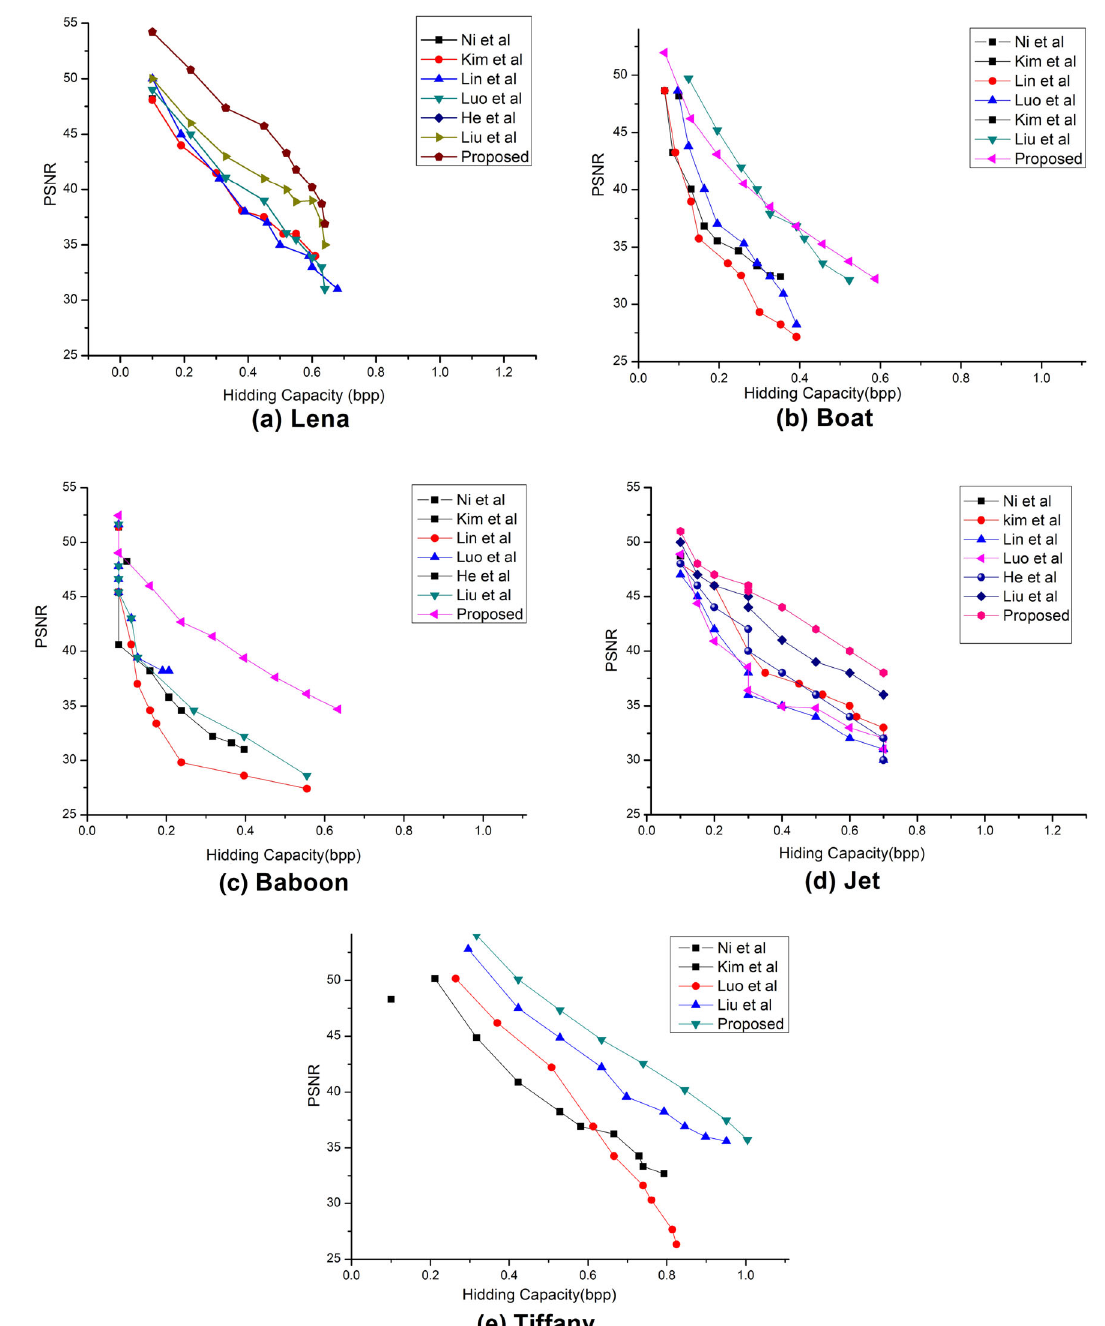
Fig. 8 Evaluation of our multi-embedding process with regard to EC and PSNR with other techniques